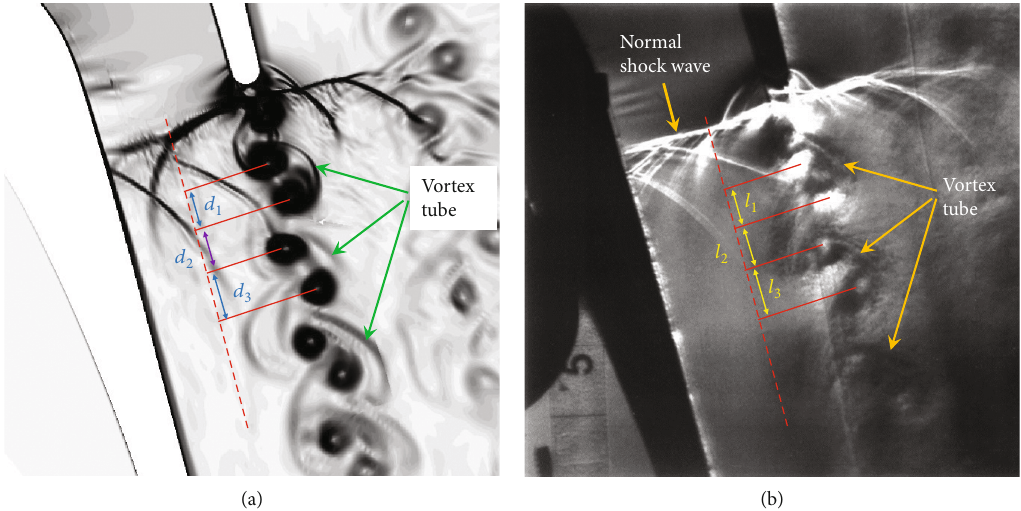
= 1 : 0 : (a) present SAS; (b) experiment [16, 20]. ex